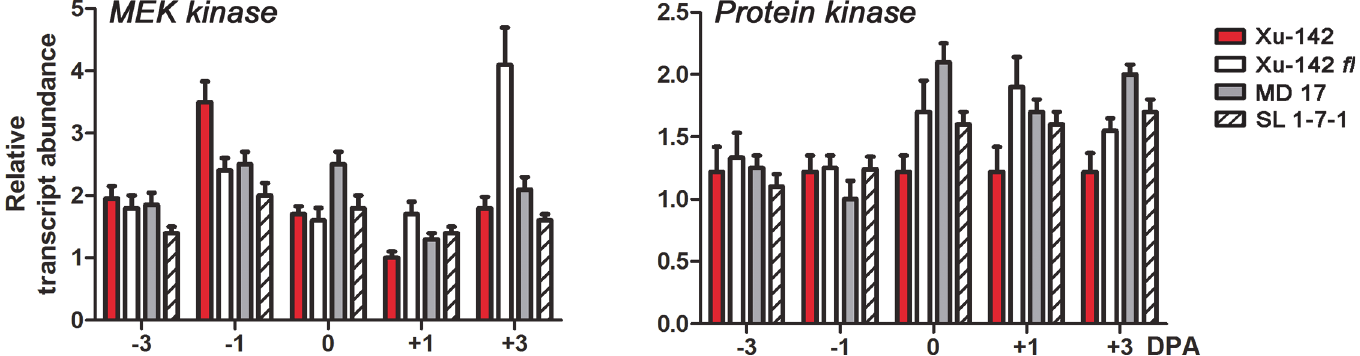
Fig 8. Expression patterns of Class 3 DEGs, genes constitutively expressed in wild type and the fiberless mutants. Transcript levels were measured by RT-qPCR from a WT (Xu-142) and three fiberless mutants (Xu-142 fl , MD 17, and SL 1-7-1) that were harvested on -3, -1, 0, 1, and 3 DPA. MEK kinase (Gorai.012G034500), and protein kinase (Gorai.008G294700). All RT-qPCR analyses were performed with three biological replications at each time point with five technical replications. The error bars represent the SD.